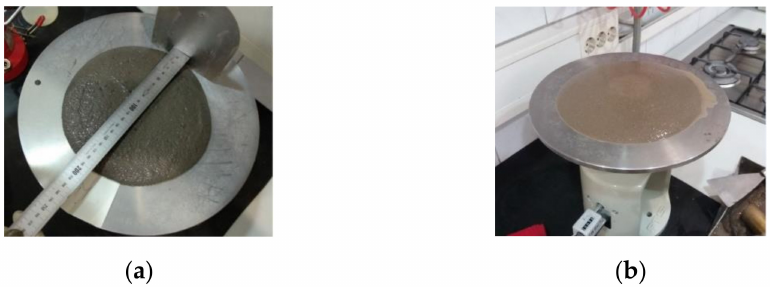
Figure 7. Flow table test: ( a ) WBA1, ( b )